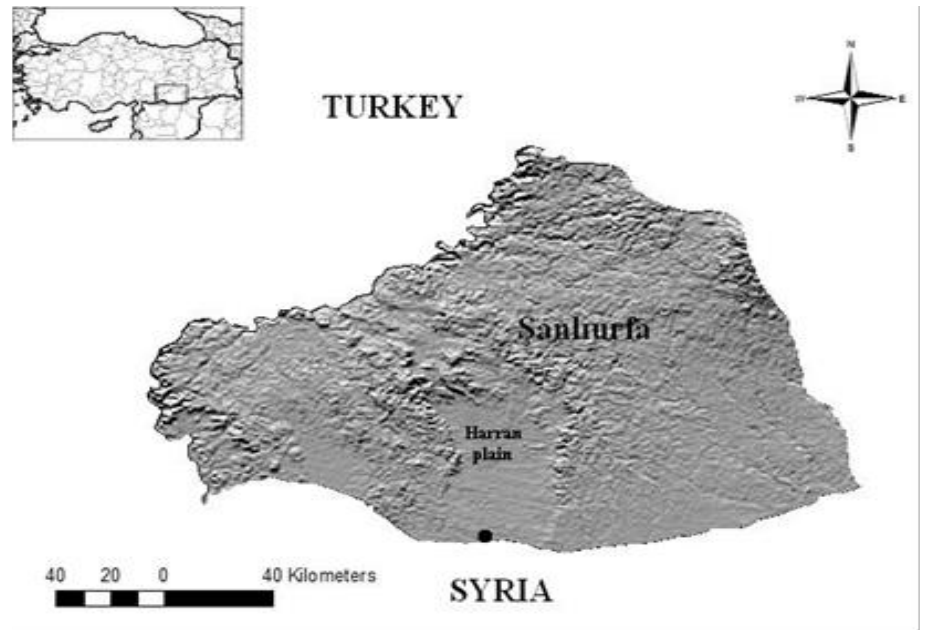
Figure 1. The places Şanlıurfa and Harran Plain in Turkey (Source: Prof. Dr. M. Ali Çullu, Faculty of Agriculture, Harran University).